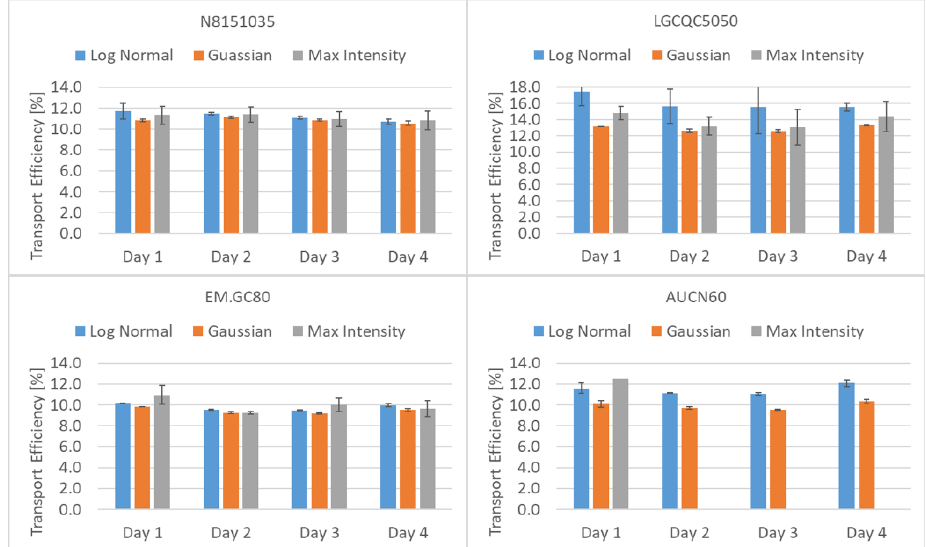
Figure 11. Transport efficiencies obtained (size approach, TES) by applying different fitting models. The software interface was unable to determine values applying the “Max Intensity method” for product AUCN60 on days 2–4.